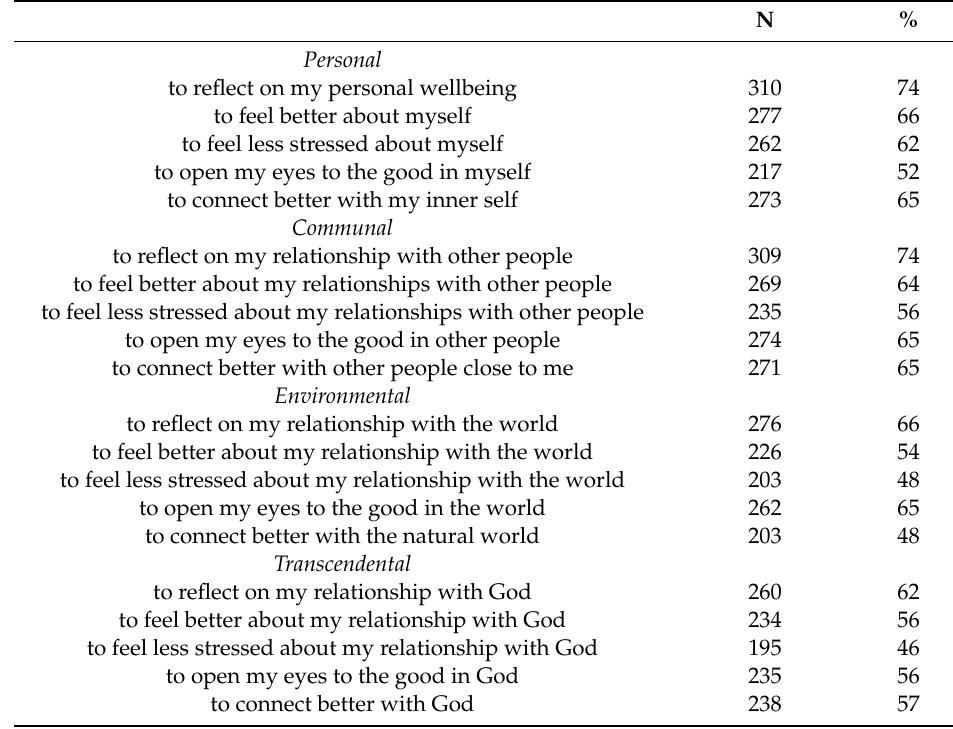
Table 15. Perceived